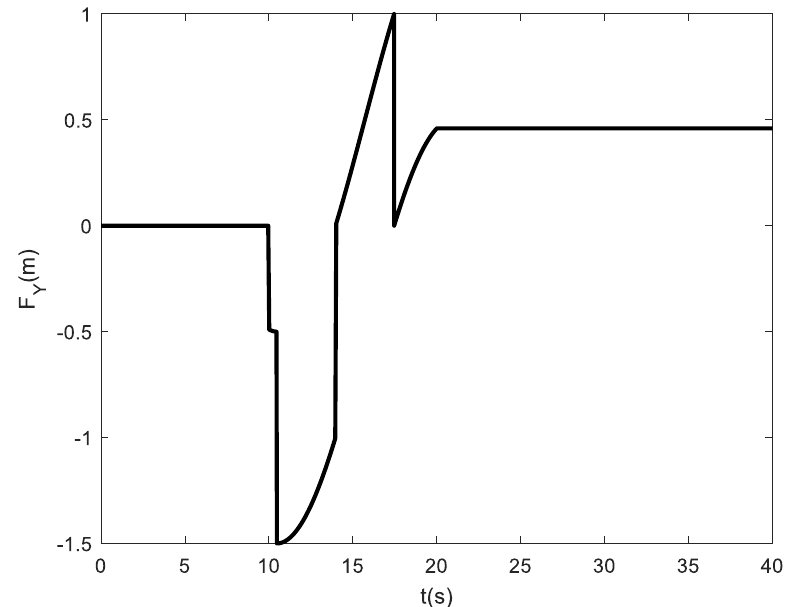
Figure 3. The curve of the disturbance in position X channel.